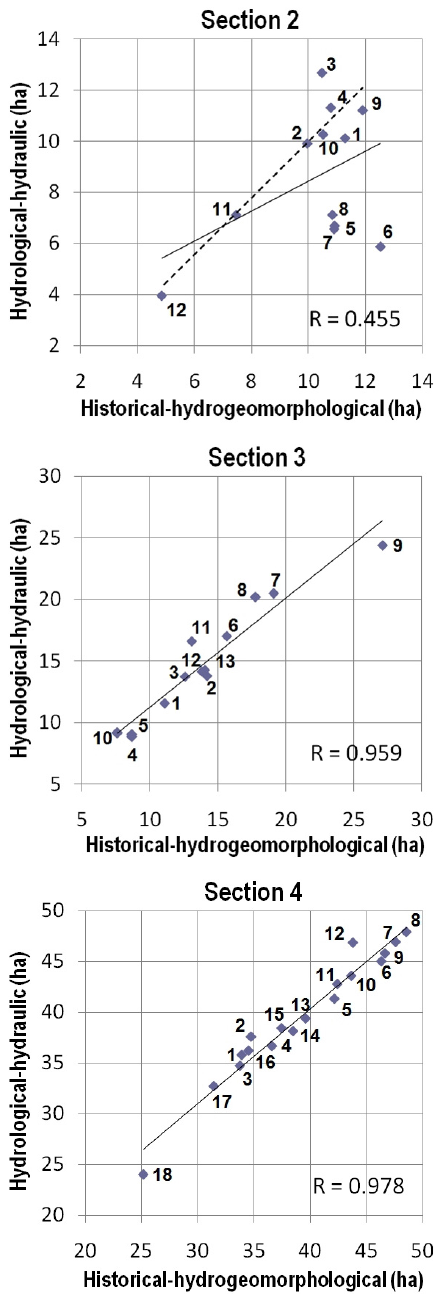
Fig. 10. Scatter plot of the flooded areas for Sects. 2, 3 and 4 ob- tained by both methods. R corresponds to the Pearson correlation coefficients (the dashed line in Sect. 2 represents the linear regres- sion line excluding blocks 5 to